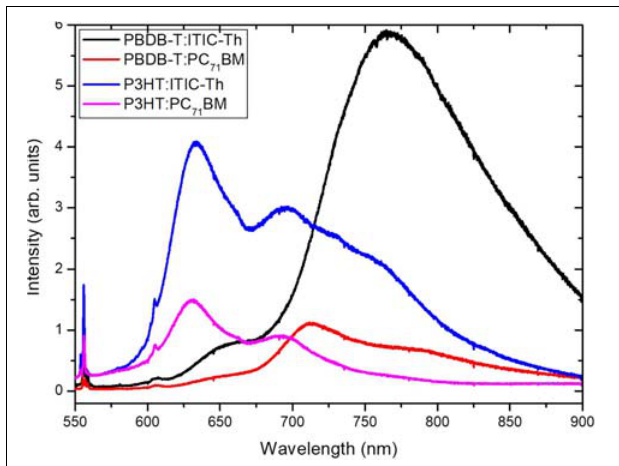
FIGURE 3 | PL spectra of different D:A thin films